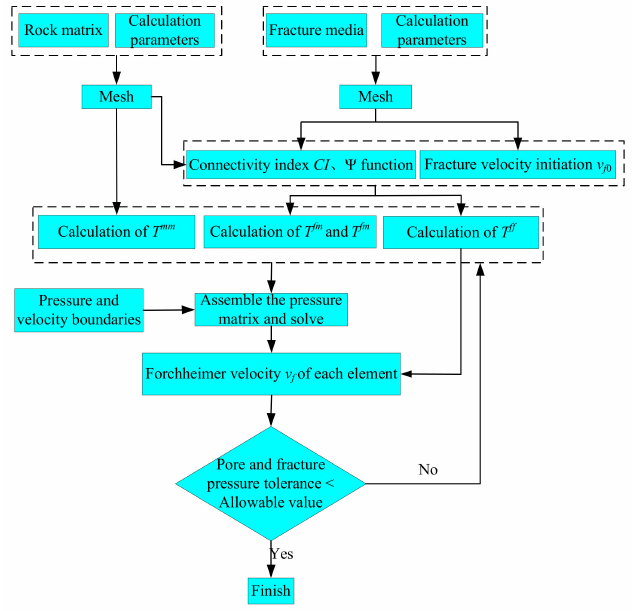
Figure 2. Flowchart of coupling Darcy–Forchheimer flow in fractured porous